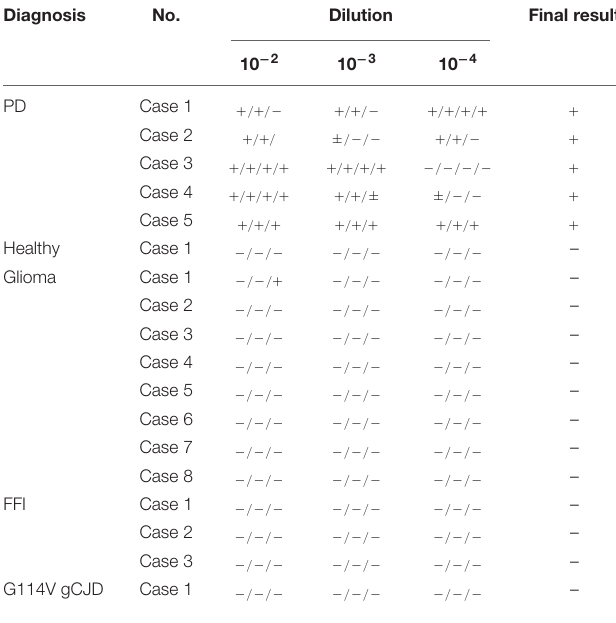
into BMG FLUOstar Omega plate reader. The working condition was temperature, 42 ◦ C; vibration speed, 400 rpm double orbital; vibration/incubation time, 60/60 s; reaction time, 80– 140. ThT fluorescence (excitation wavelength, 450 nm; emission